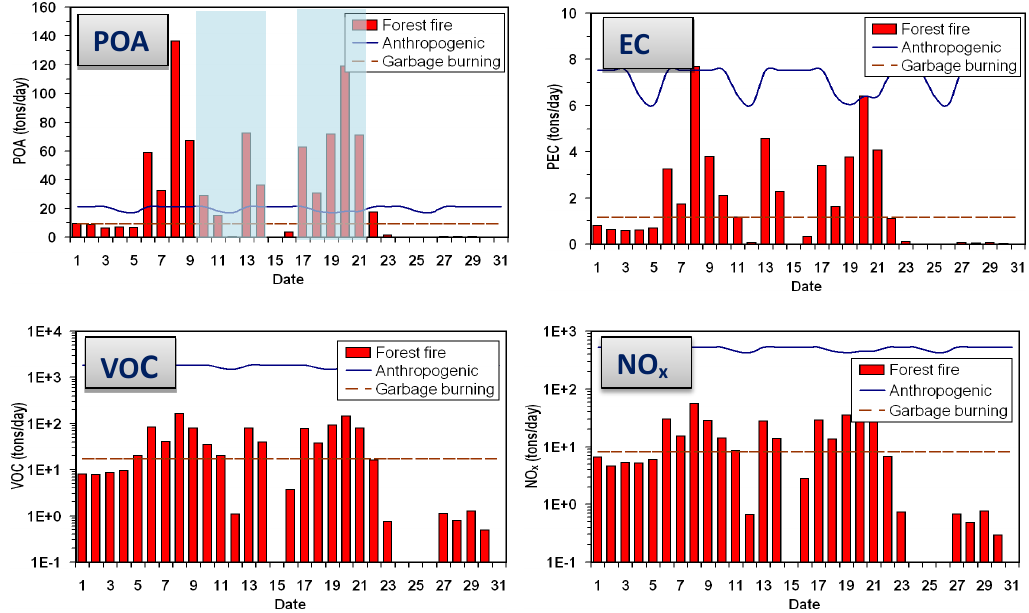
Fig. 3. Emissions of anthropogenic sources, open fires and trash burning in the MCMA during the MILAGRO campaign. The red bars denote the daily emissions of open fires (dominantly forest fires), the blue line denotes the emissions from the fossil fuel use, and the brown dash line denotes the garbage burning emissions. The blue bars indicate the simulation